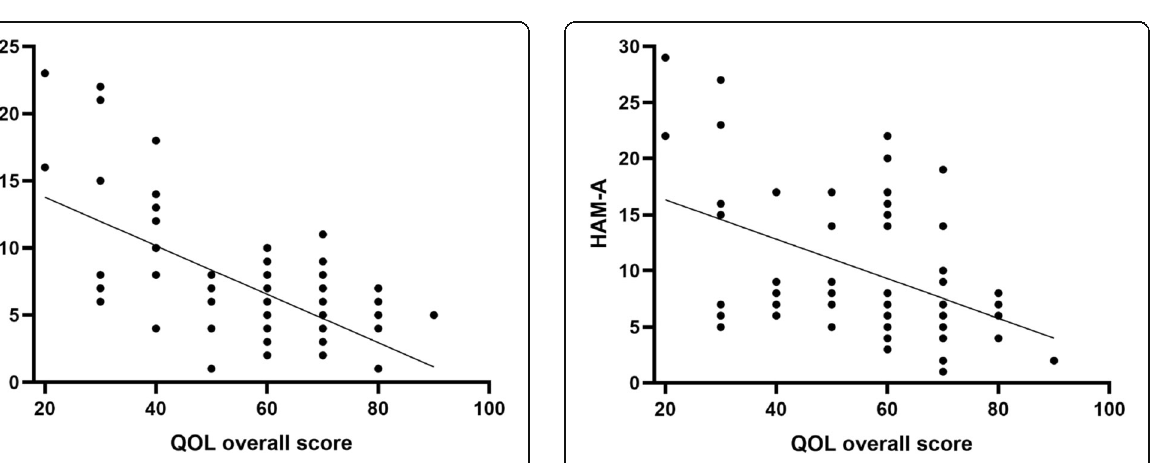
Fig. 2 Correlation between overall QOL and HAM-A scale. Significant weak negative correlation between overall QOL and HAM-A scale, r = − 0.452, P <